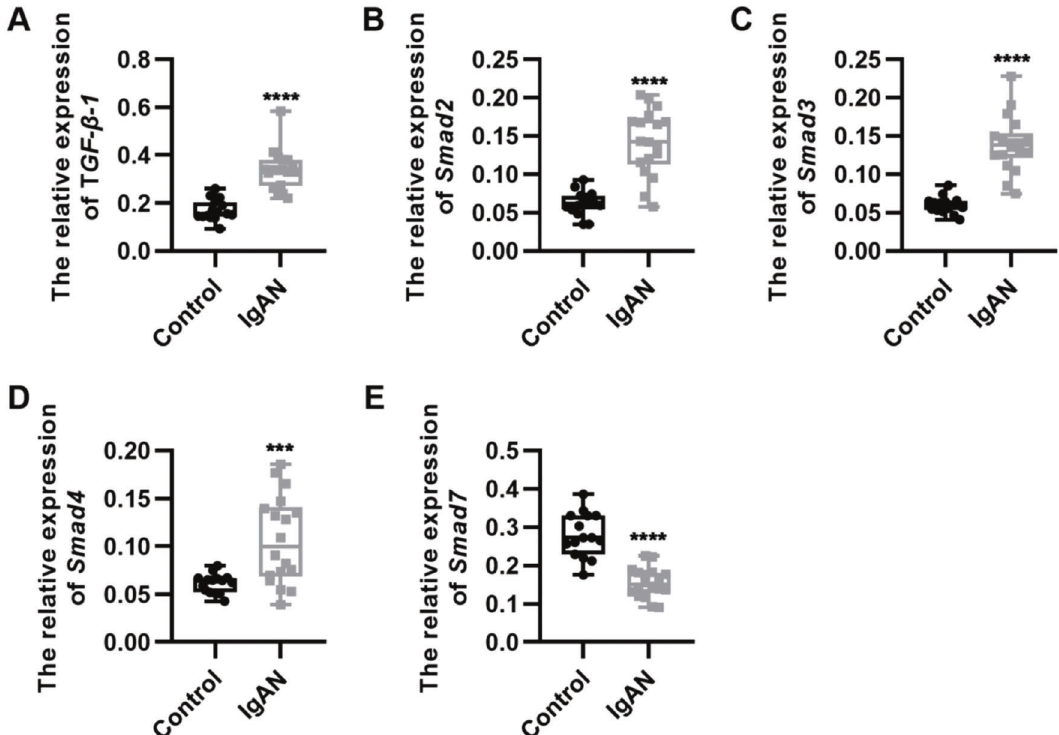
Figure 1 - Key components of the TGF- b 1/Smad3 signaling pathway are upregulated in patients with IgAN. (A–D) Expression levels of TGF- b 1 (A), Smad2 (B), Smad3 (C), and Smad4 (D) are upregulated in patients with IgAN. (E) The expression level of Smad7 is downregulated in patients with IgAN. IgAN: Immunoglobulin A nephropathy, *** p o 0.0001 and **** p o 0.00001, Mann–Whitney U test (A), unpaired Student ’ s t -test